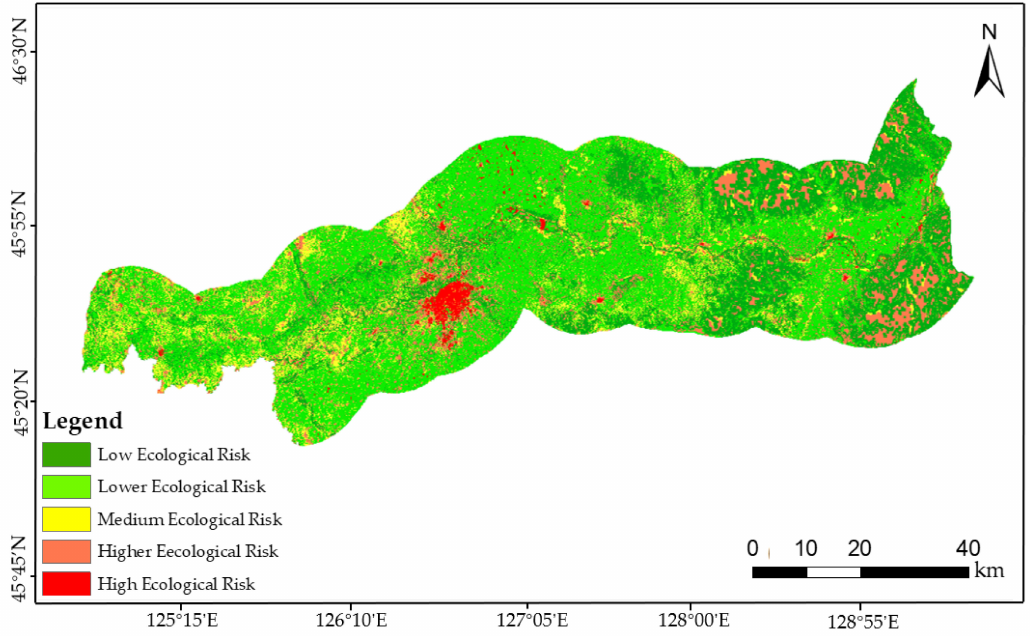
Figure 7. The map of spatial distribution of landscape ecological risks in the buffer